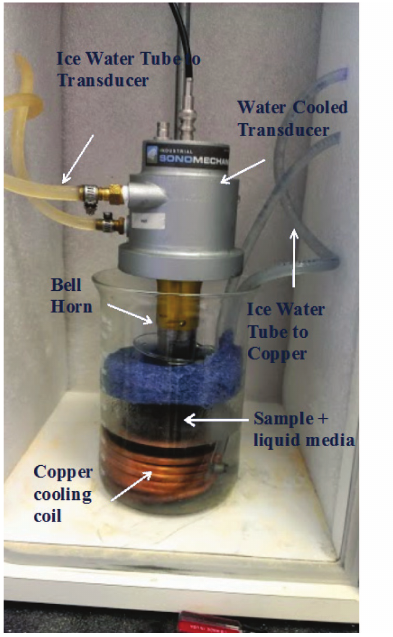
Figure 10. Ultrasonic horn setup. Note that a cooling bath was used to maintain a constant temperature, however the bath that included the cooling coil and the sample in the liquid media were not in contact. The latter were placed in a second beaker. The blue foam was used to keep the inner beaker in